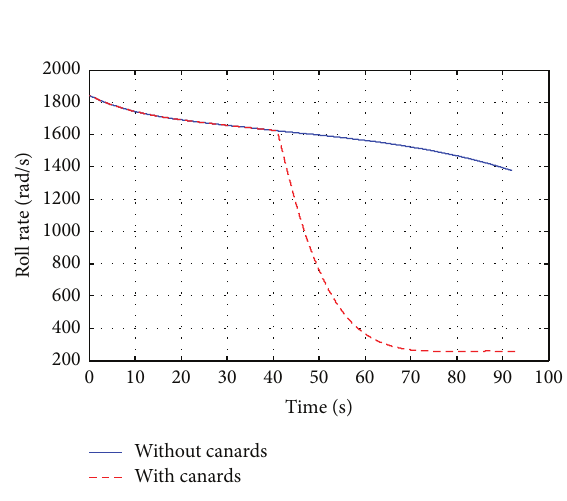
Figure 13: Drift versus range.